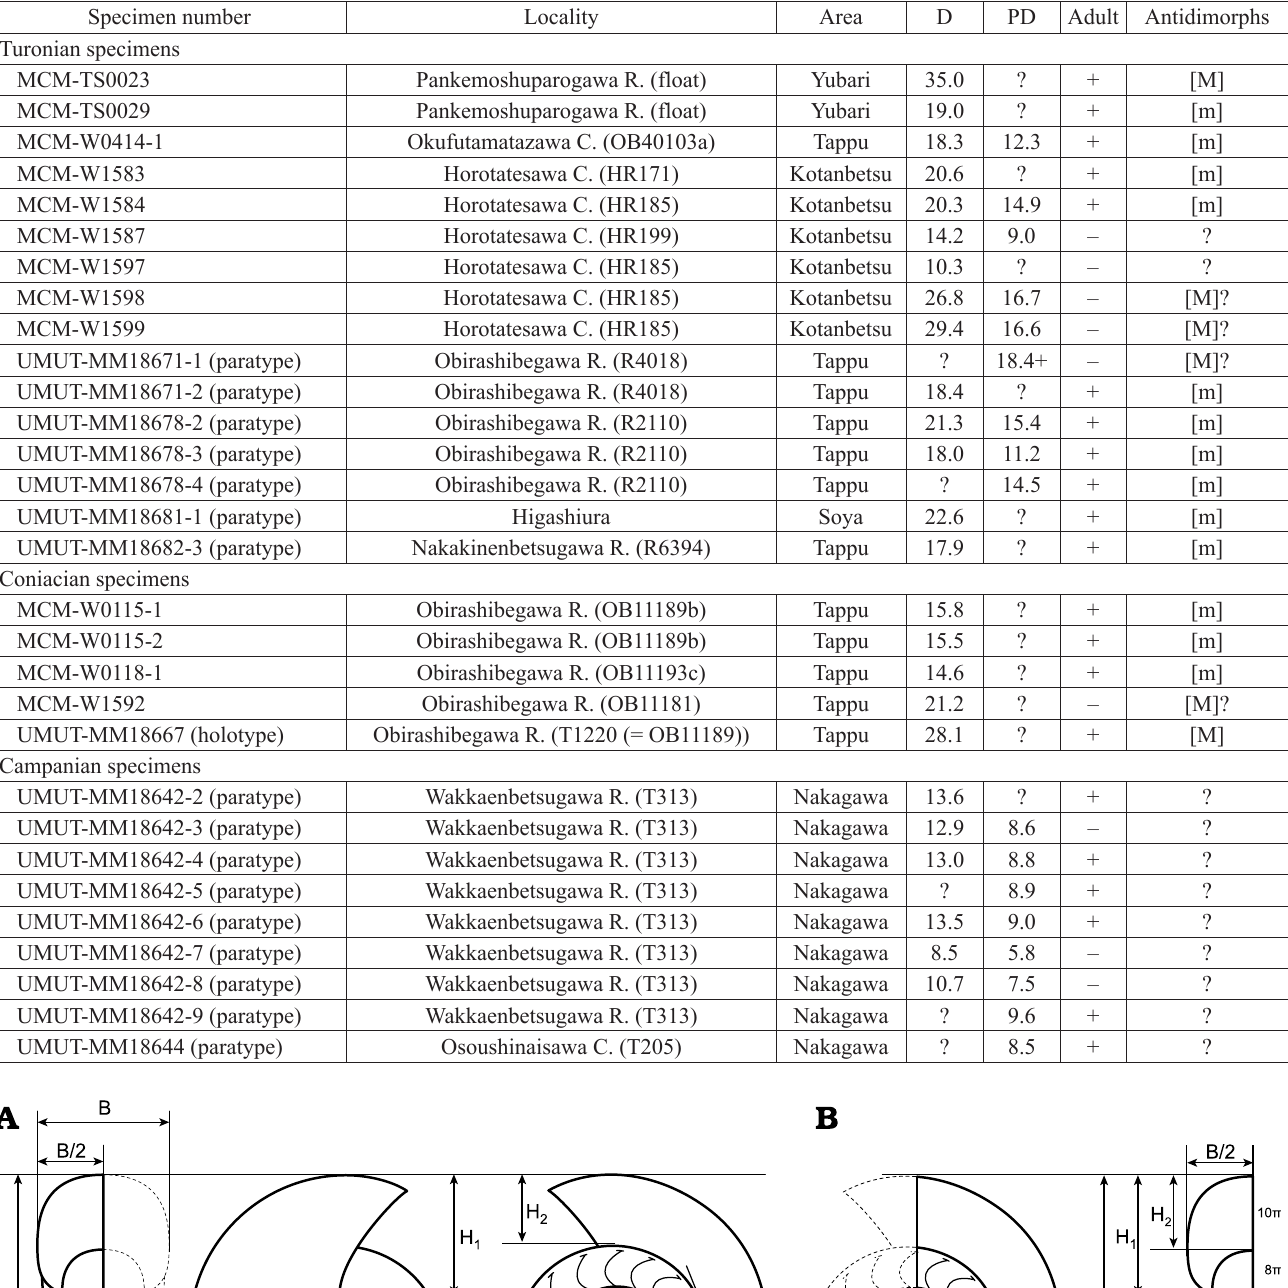
Table 2. List of Turonian, Coniacian, and Campanian specimens of tetragonitid ammonoid Tetragonites minimus Shigeta, 1989, from the Yezo Group in Hokkaido, Japan. Measurements in mm. Abbreviations: C., Creek; D, shell diameter; [m], microconch; [M], macroconch; PD, phrag- mocone diameter; R., River; + satisfied; – unsatisfied; ?, unmeasurable or undecidable.